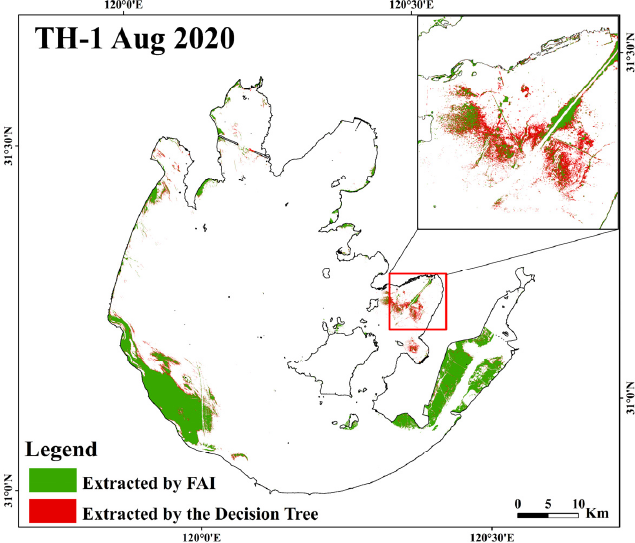
Figure 8. Comparison of the effect of vegetation extraction with strict FAI fetching and with the decision tree in Lake Tai on 1 August 2020.